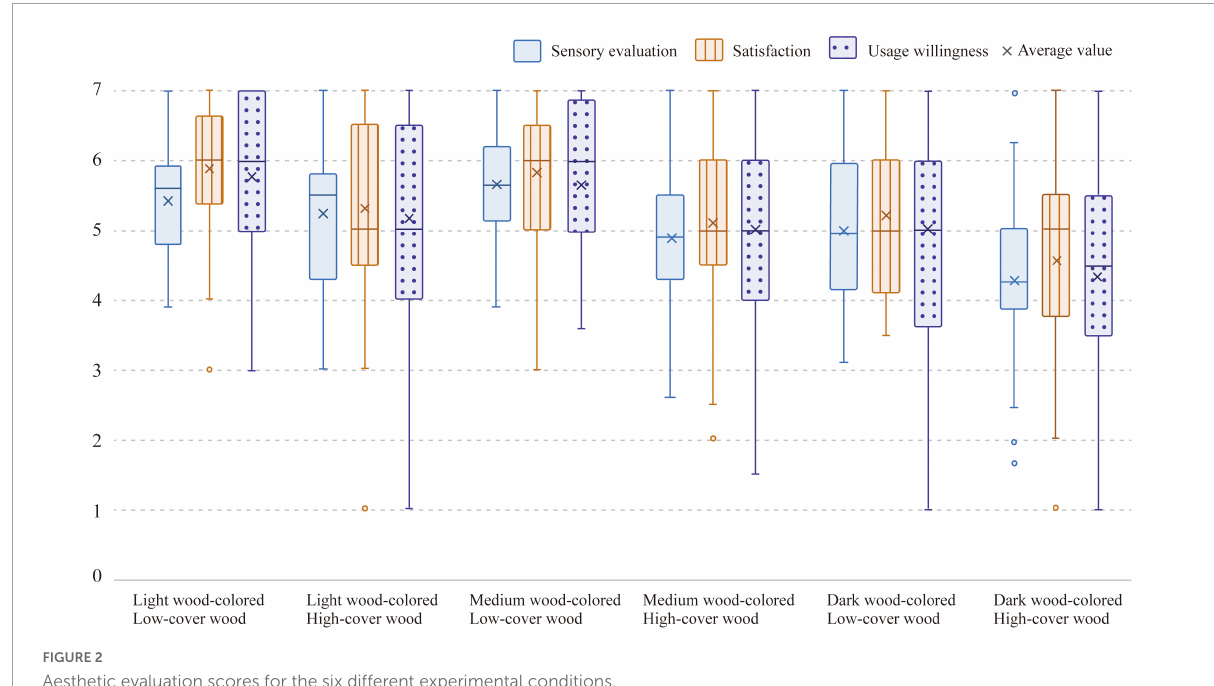
FIGURE2 Aesthetic evaluation scores for the six different experimental